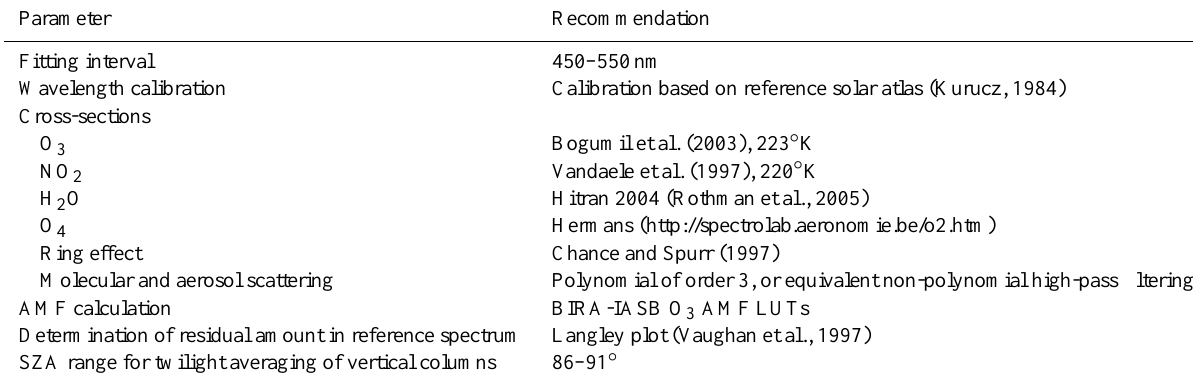
Table 1. Settings recommended for the UV-visible retrieval of O 3 vertical columns.